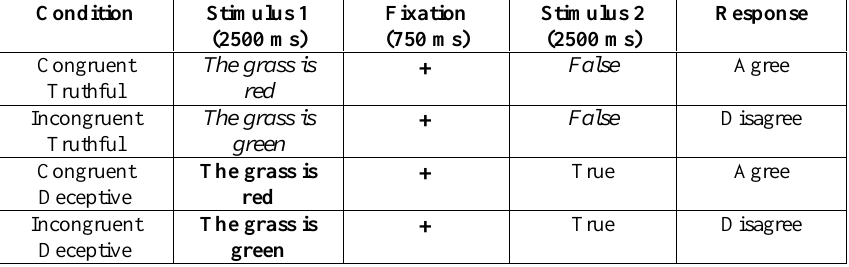
Fig. 2. Time course of stimulus administration for the two-stimulus paradigm in Experiment 1.